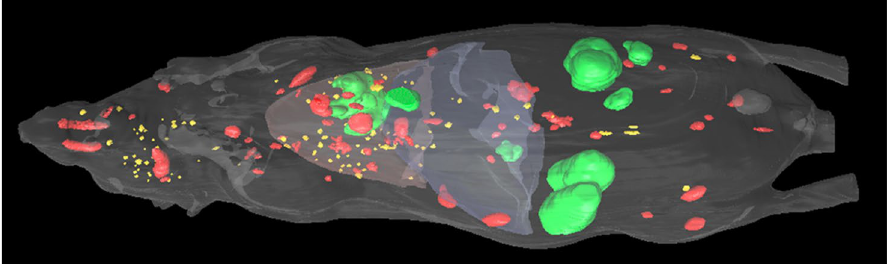
Figure 4. 3D visualization of manually annotated metastases in one mouse. Tumor labels are rendered in green (> 2 mm), red (0.5–2 mm), and yellow (< 0.5 mm). The brown and blue semi-transparent regions represent lung and liver, respectively.